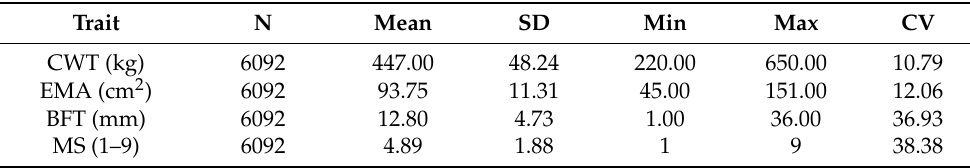
Table 2. Descriptive summary 1 on carcass traits of Hanwoo